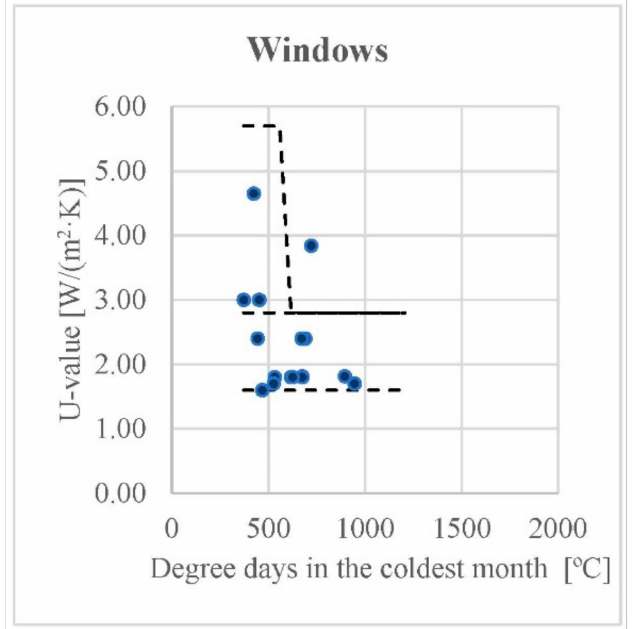
Figure 3. Law for the assignment of window U-values with heating degree days in the coldest month in each